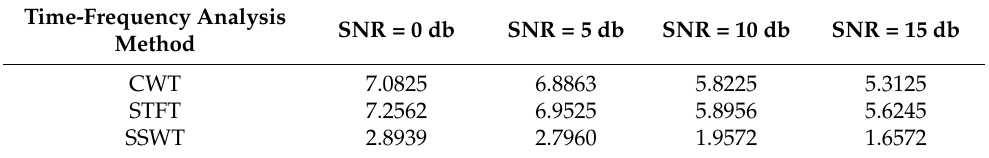
Table 1. Rayleigh entropy comparison of different time-frequency analysis methods under different noise conditions.